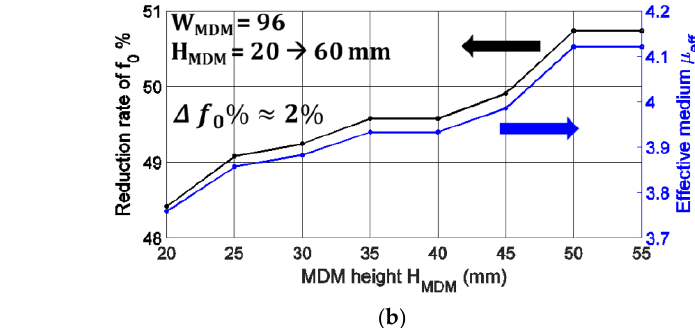
Figure 7. ( a ) Monopole antenna of the height 200 mm with two slots of the width 50 mm. ( b ) Reduction rate of f 0 and µ eff in function of P-MDM height H MDM with a constant W MDM = 96 mm.